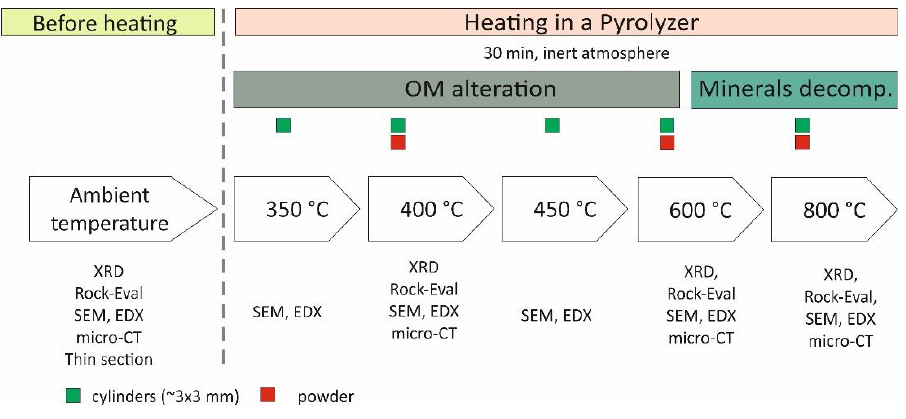
Figure 3. Schematic representation of the experiment.